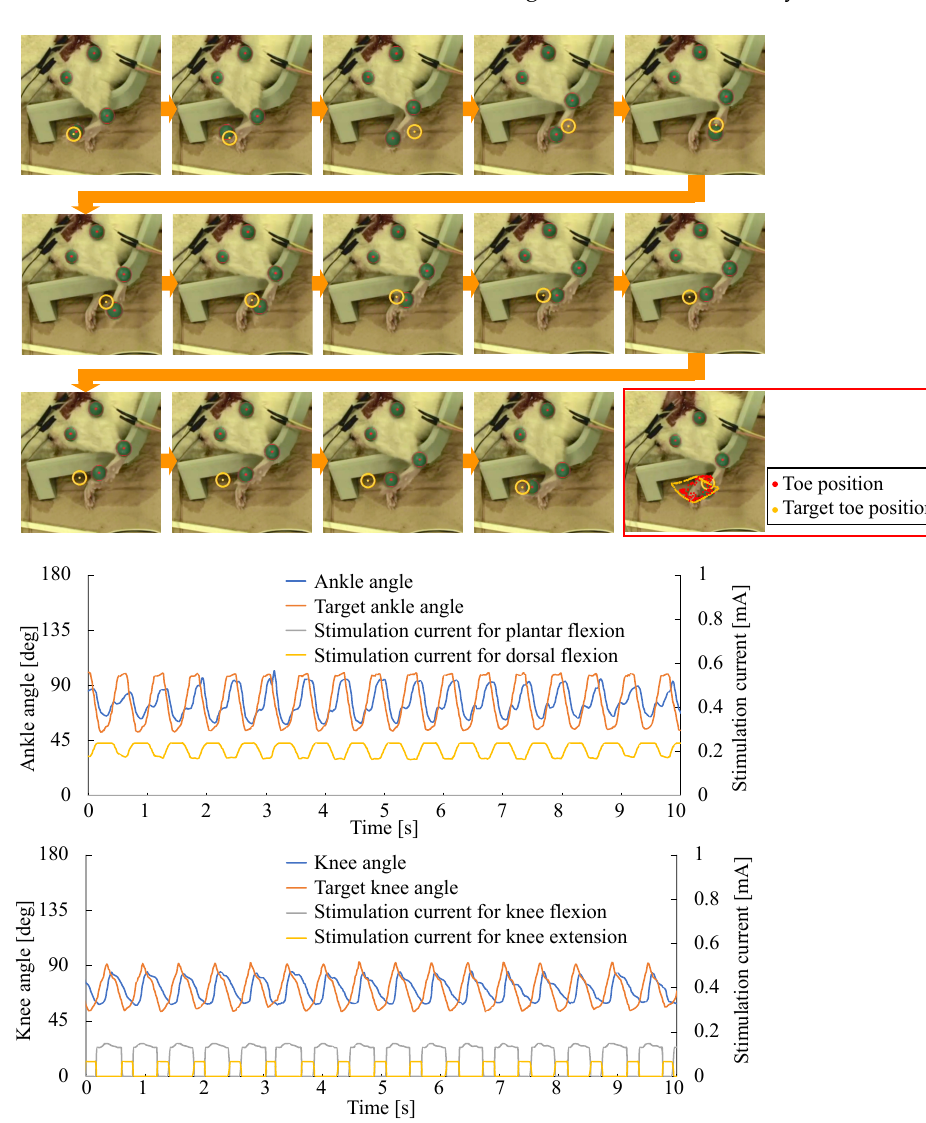
Figure 10. Reconstruction of walking trajectory by ankle and knee joints control. Upper photos indicate the motion of the rat leg during one cycle of the walking trajectory (the orange dot in the orange circle indicates the target position of the rat toe). The right bottom photo (inside the red rectangle) shows the trajectory of the rat toe and the target rat toe in the experiment. Lower graphs show the joint angle, target joint angle, and stimulation currents to the nerves during the